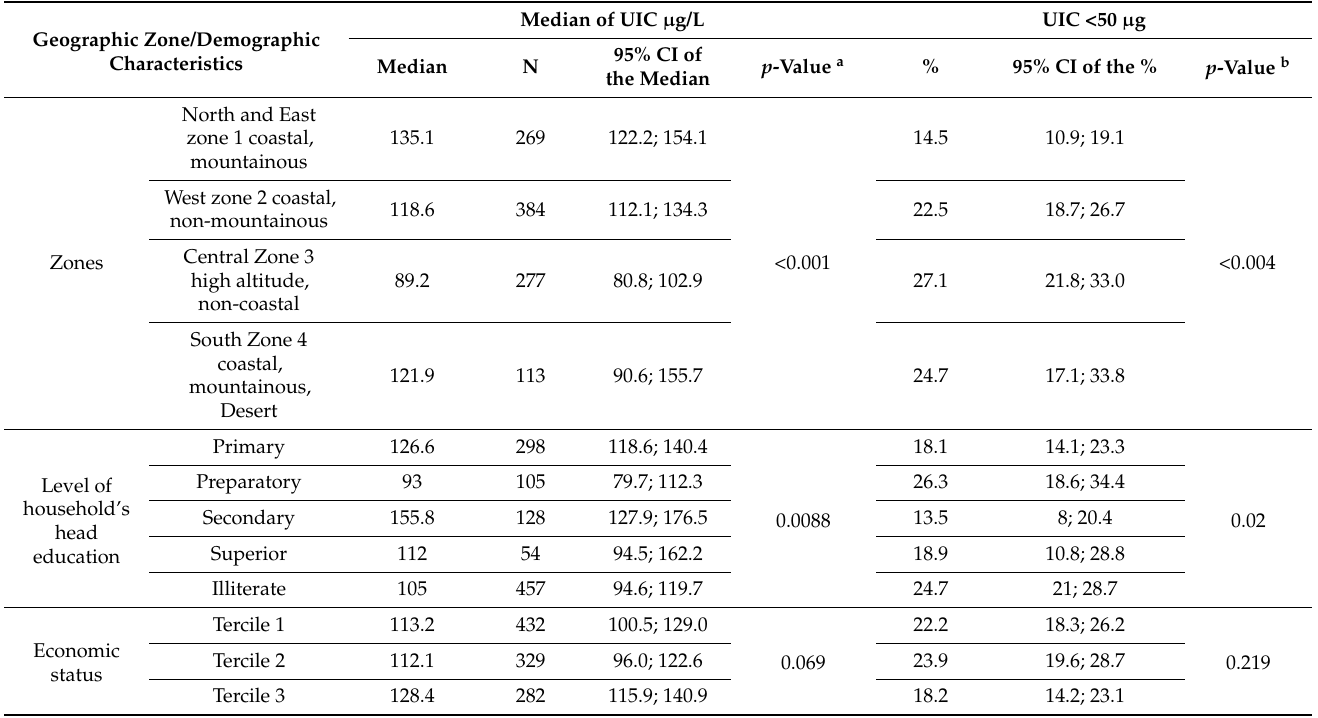
Table 3. Median urinary iodine concentration (mUIC) and the number and percentage of surveyed samples with UIC < 50 µ g/L according to head-of-household education level, geographic zone, and socio-economic status. Geographic Zone/Demographic